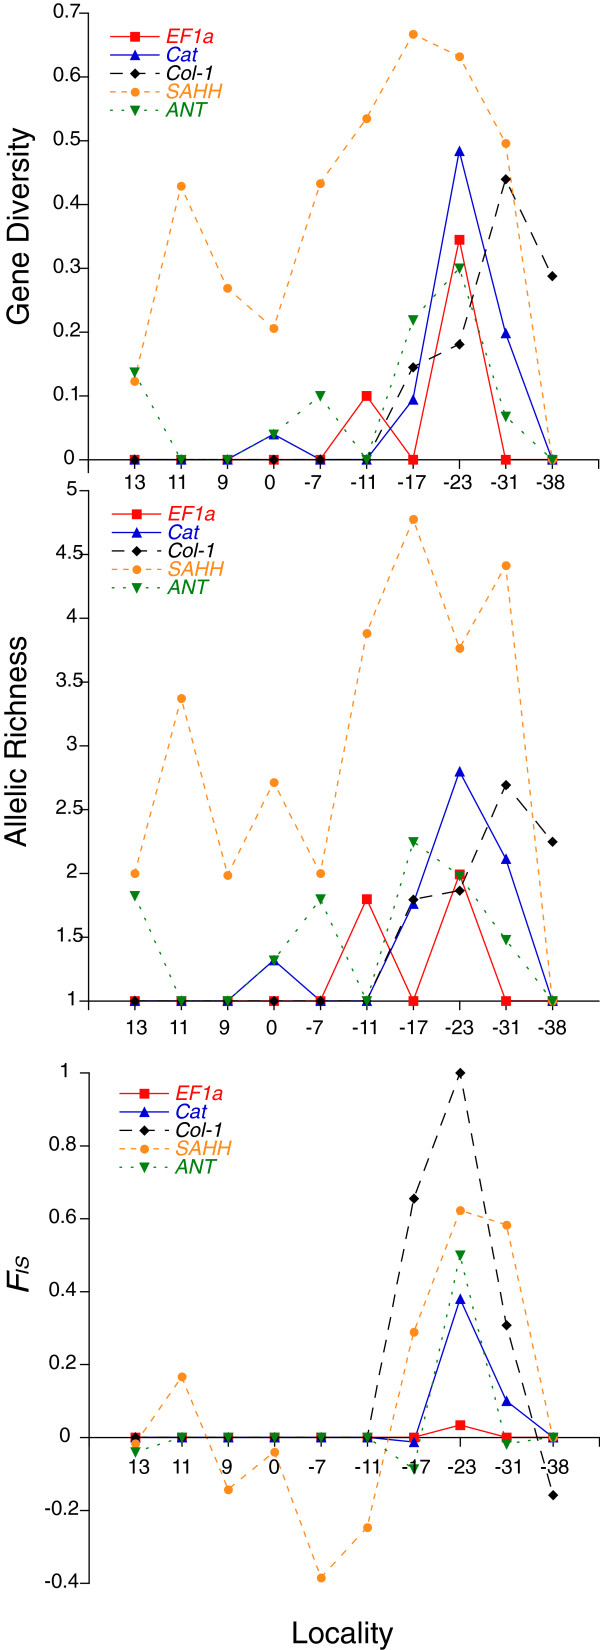
Statistical estimates of (a) gene diversity, (b) allelic richness, and (c) heterozygote deficiencies (
F

IS

) for nuclear loci for mussel populations at each locality.